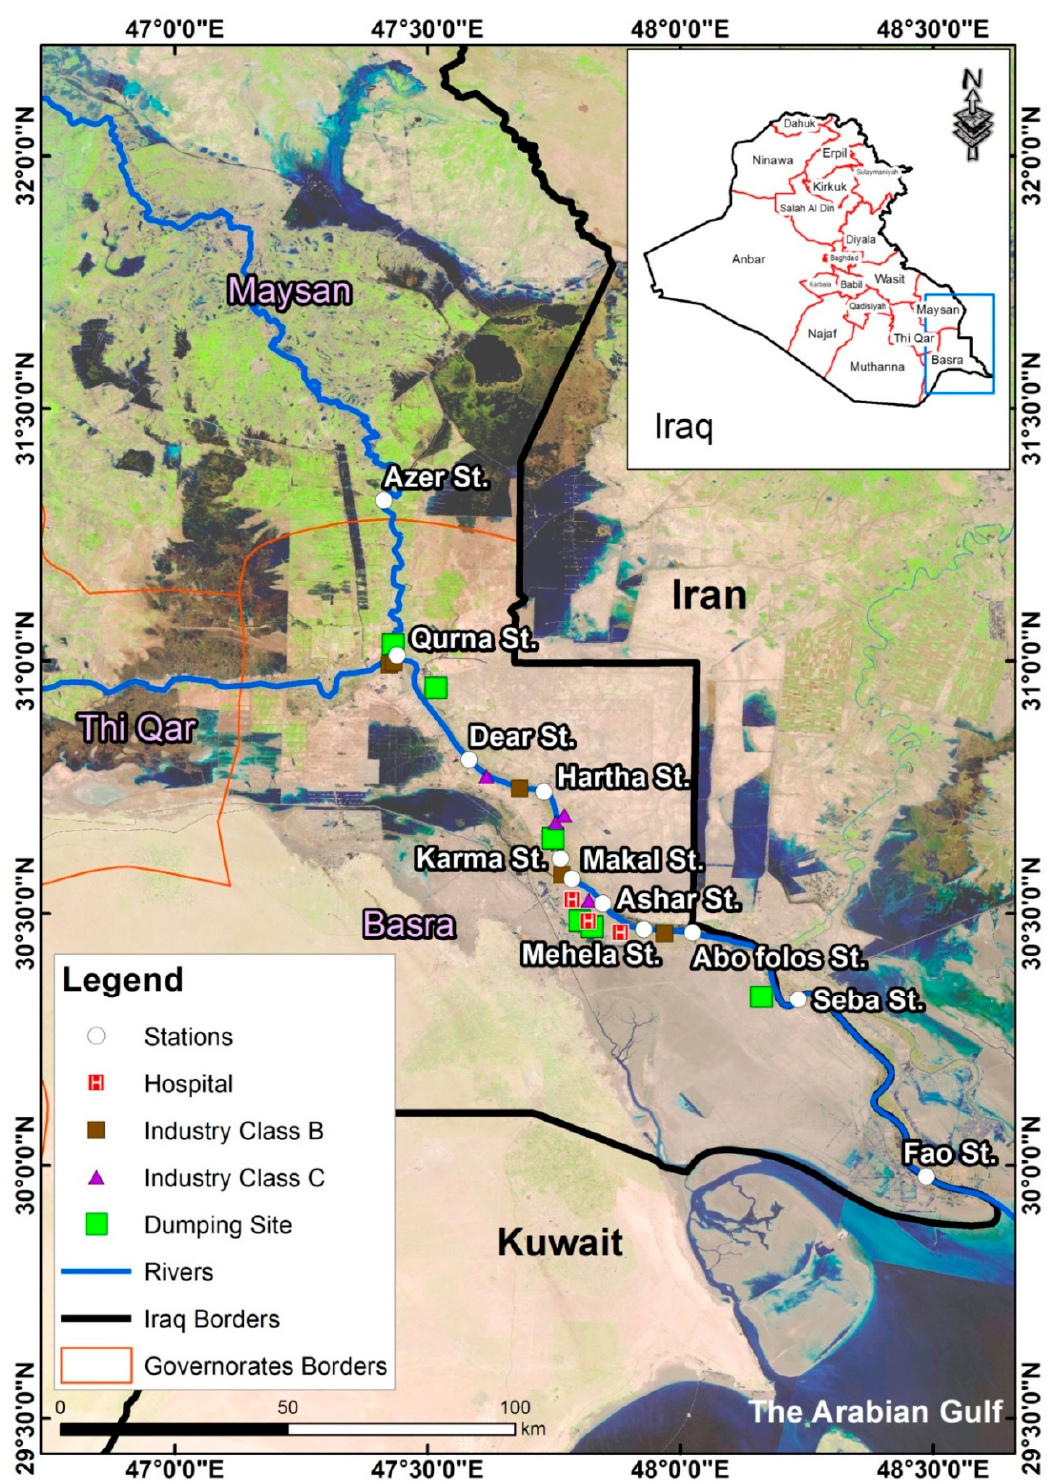
Figure 1. Locations of the sampling stations selected in the present study and showing the most important polluting sources of the Shatt Al-Arab River including; sanitary landfill sites, health activities, and industrial activities of types B and C, according to the classification of Iraqi legislation for river